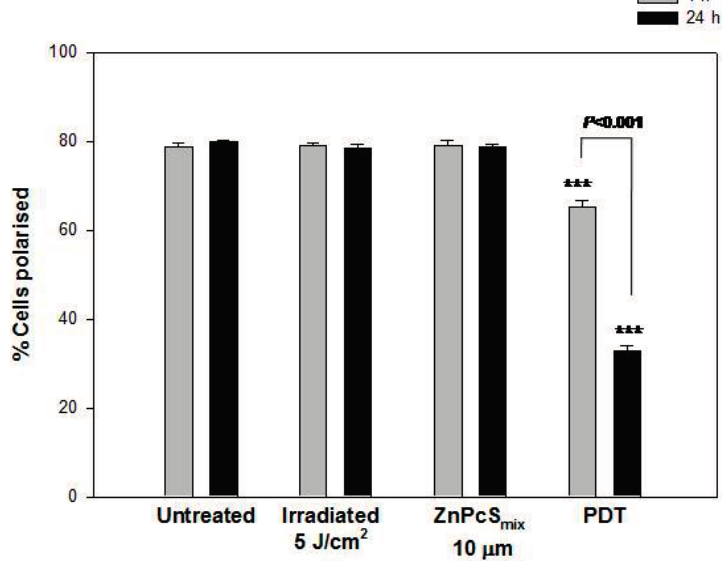
Figure 4. Mitochondrial membrane potential (MMP) was evaluated using JC-1 dye by flow cytometry ( n = 4). Untreated multicellular tumour spheroids (MCTSs) showed an increased percentage of polarized cells 1 and 24 h post PDT. Irradiated MCTS and those that received ZnPcS mix (10 µM) in the absence of light also showed an increased percentage of polarized cells. There was a reduction in the percentage of polarized cells in 1 or 24 h post PDT ( p < 0.001). Significant differences between untreated controls and the experimental groups are represented in the graph as *** p < 0.001.